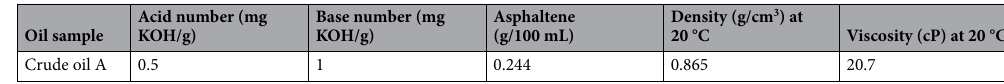
Table 8. Crude oil properties, as reported by Mahani et al. 19 .